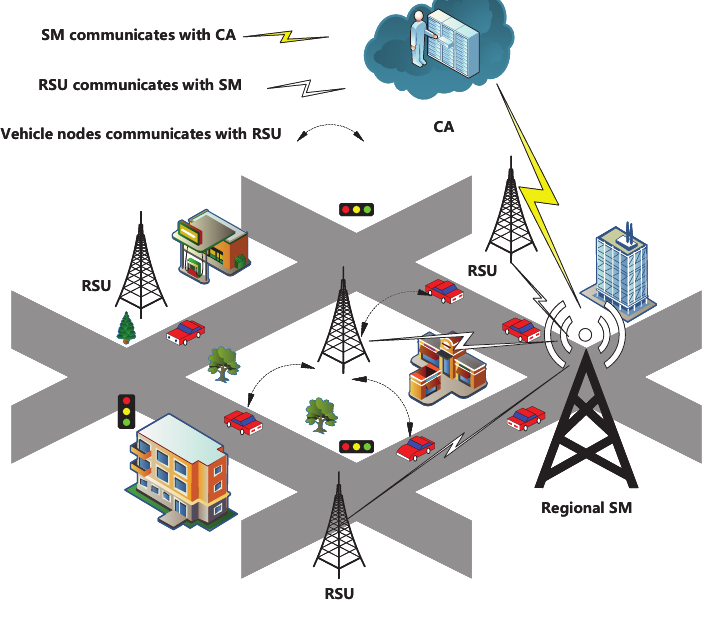
Figure 1. Traditional intelligent ground transportation system